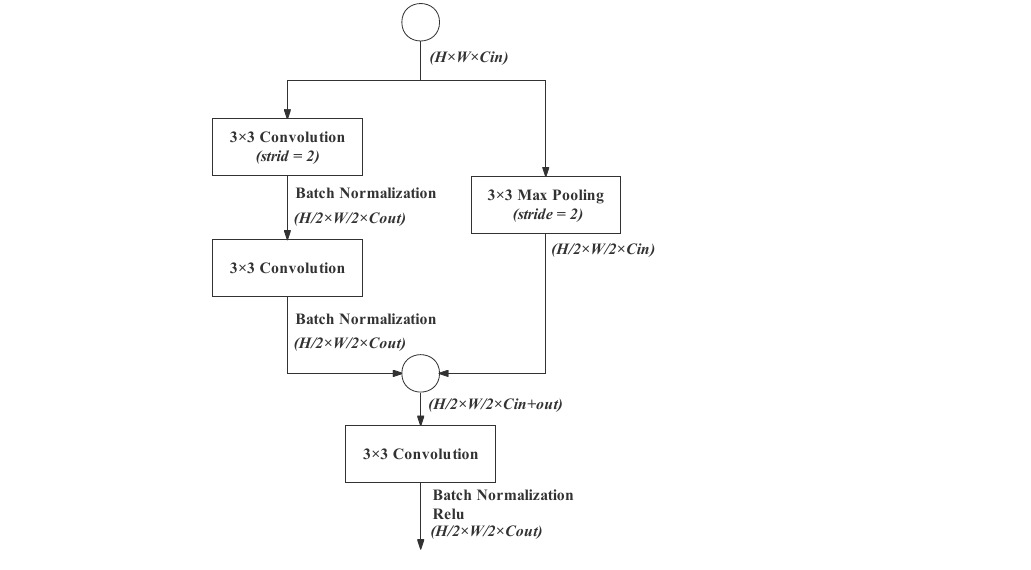
Figure 3. Stem block. Notation: “3 × 3” in operation blocks denotes the operation’s kernel size; stride denotes the times of downsampling; the (H × W × C) label beneath each operation refers to the size of the output feature map (image); H: height, W:width, C: channel, while Cin denotes input channel and Cout denotes output